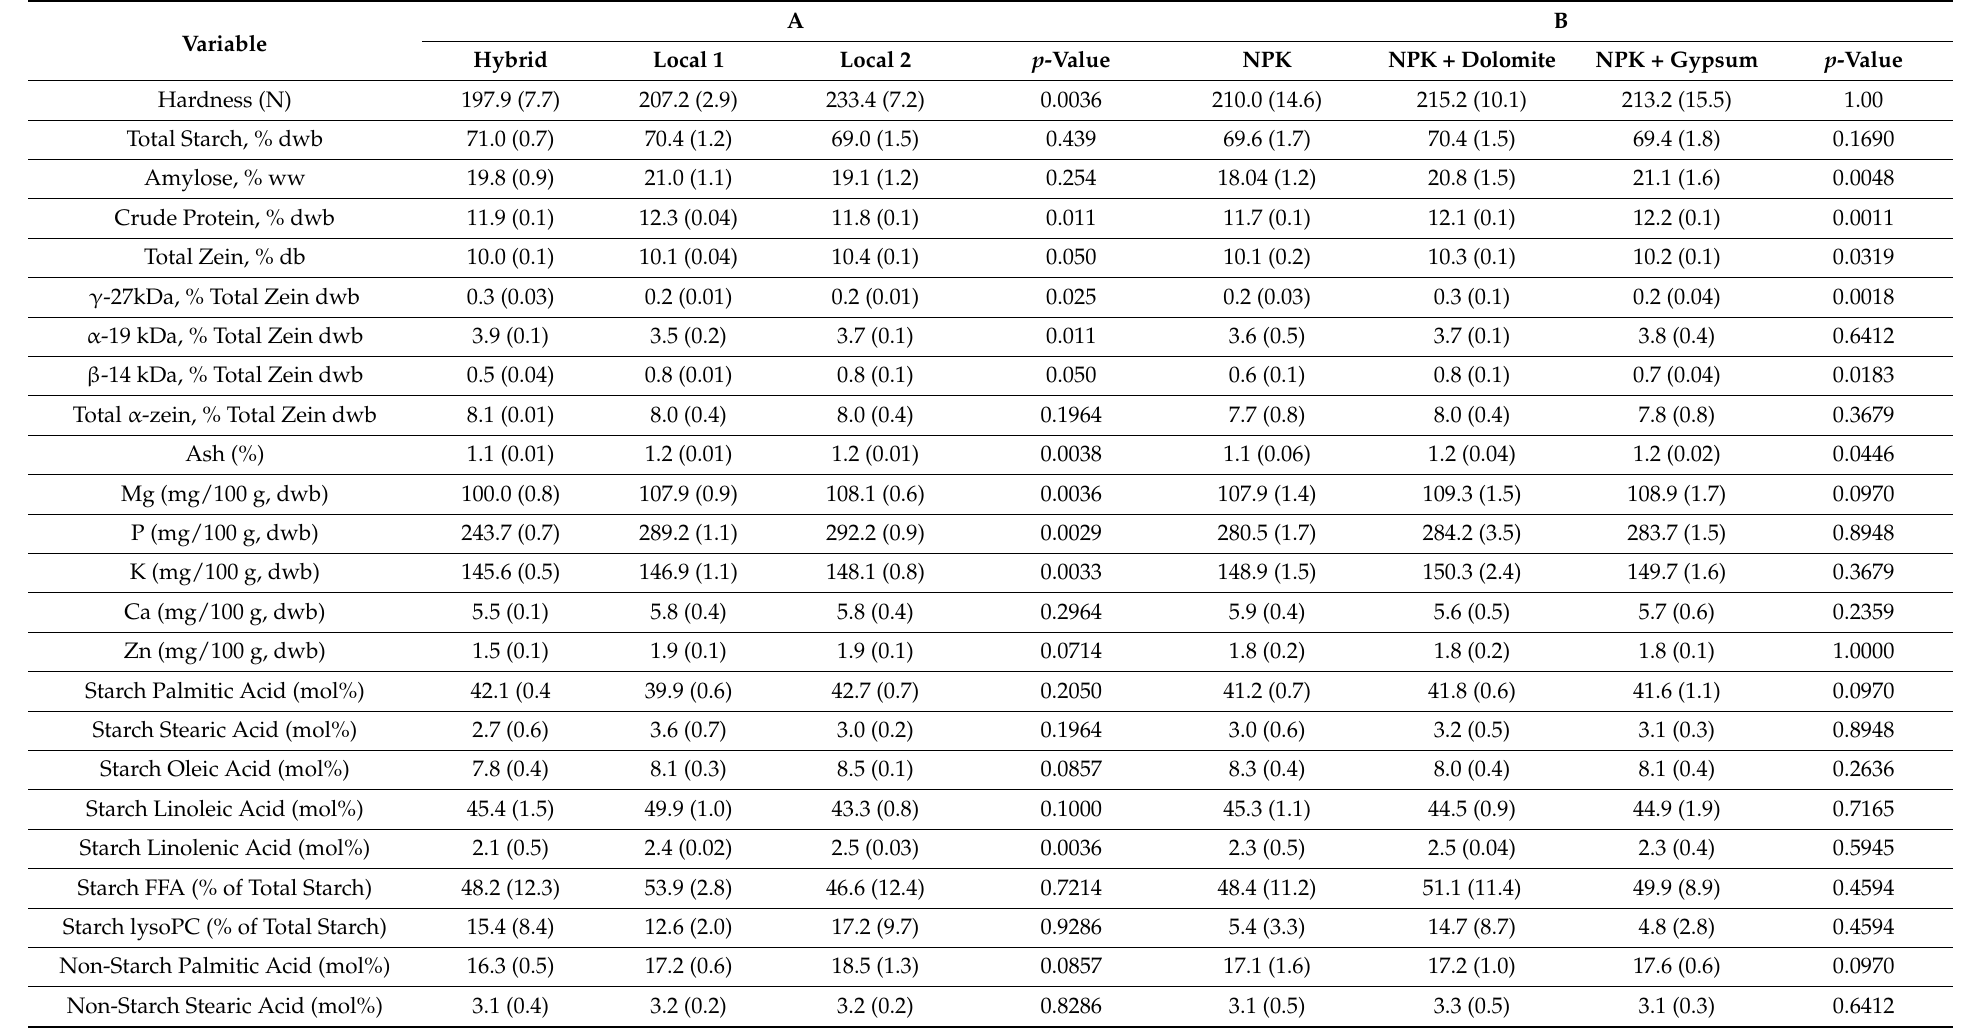
Table 4. Differences among maize varieties ( A ) and among fertilizer treatments ( B ) in physical and chemical